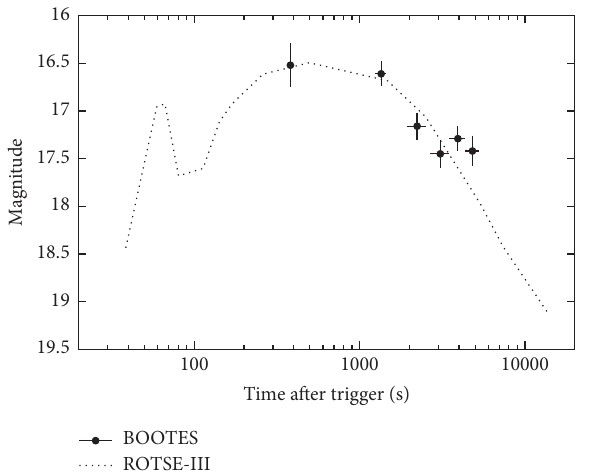
Figure 3: The optical light curve of GRB 080330. The dotted line shows the light curve as seen by ROTSE-III [27].